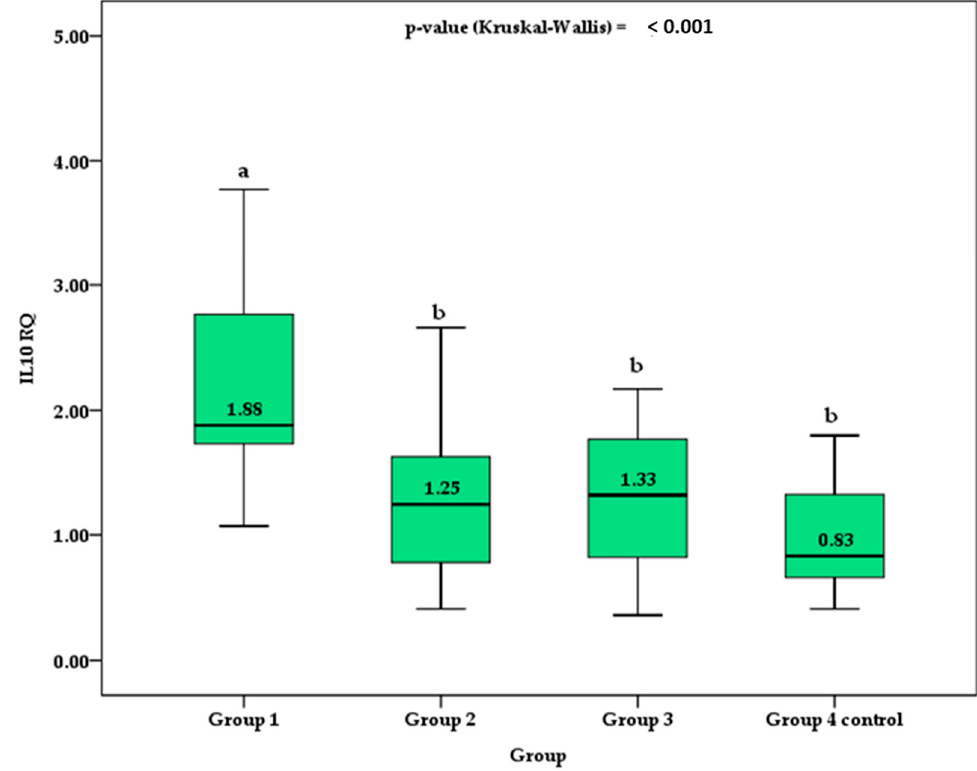
Figure 1. Comparison of the median and interquartile range (box) of IL-10 RQ between groups. Different superscript letters indicate a significant difference between the means by the post hoc Holm–Sidak test for p -value < 0.050.